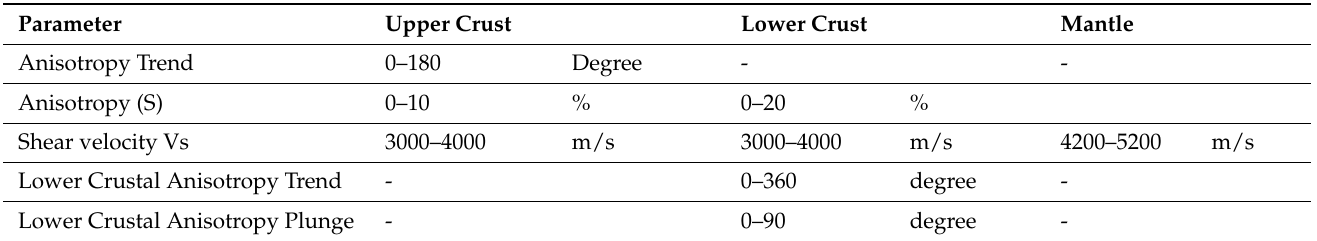
Table 1. Ranges of values searched for each free parameter.